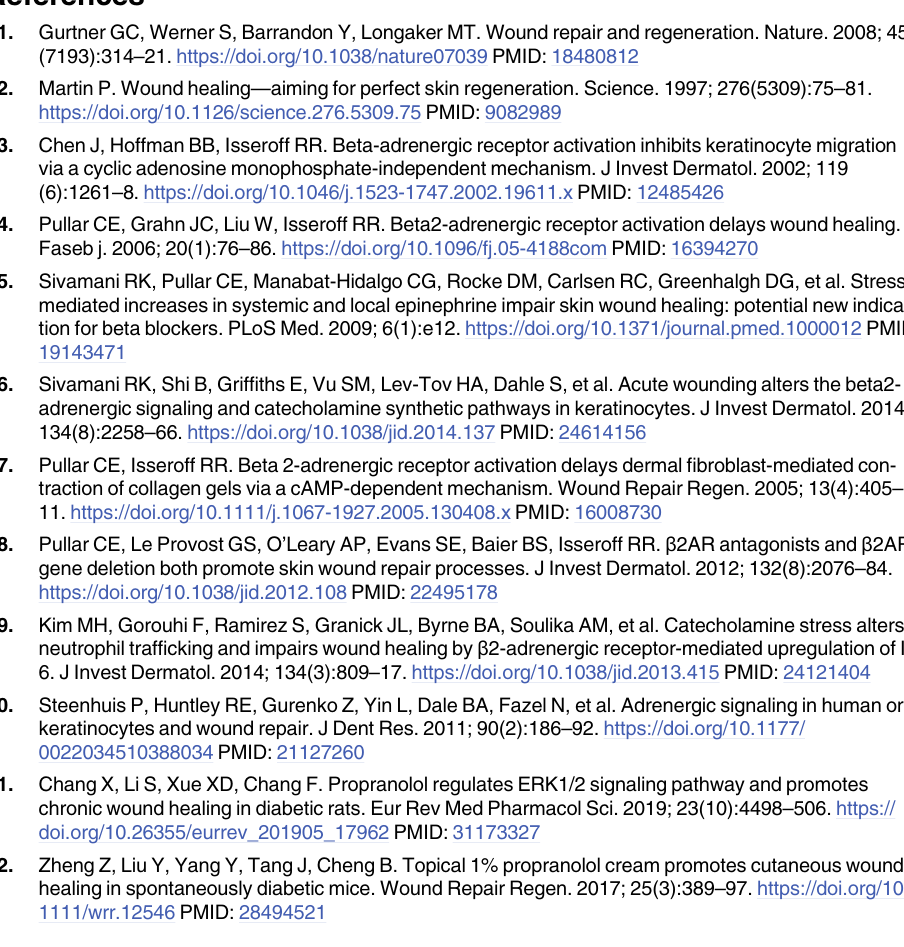
S1 Fig. Raw images of the original Western blots. The original blots for Fig 1C, 2C and 2D.